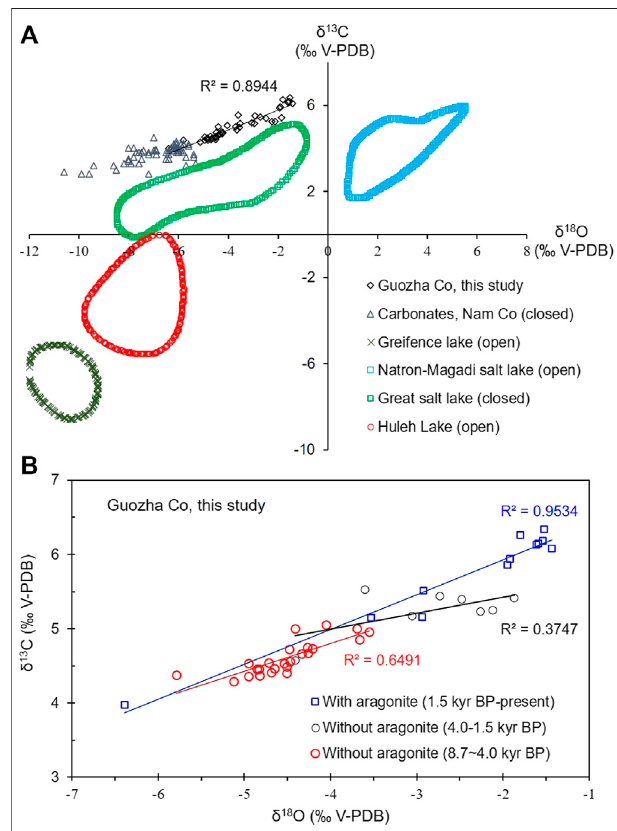
FIGURE 6 | Comparison of the δ 18 O ( ‰ VPDB) and δ 13 C ( ‰ VPDB) valuesfrom (A) GuozhaCoandotherlakes (B) fromdifferentstagesinGuozha Co. The δ 18 O and δ 13 C data for Nam Co are from Li et al. (2012), and the data for the other lakes are from Talbot